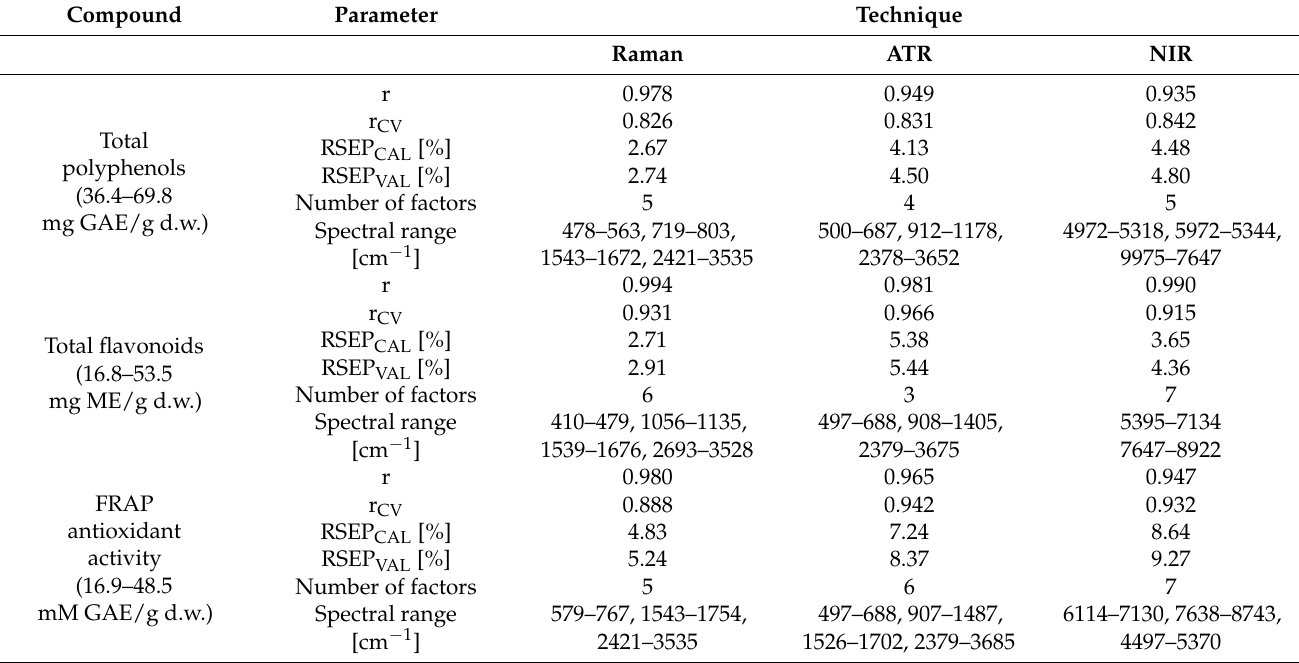
Table 1. Calibration parameters of the developed PLS